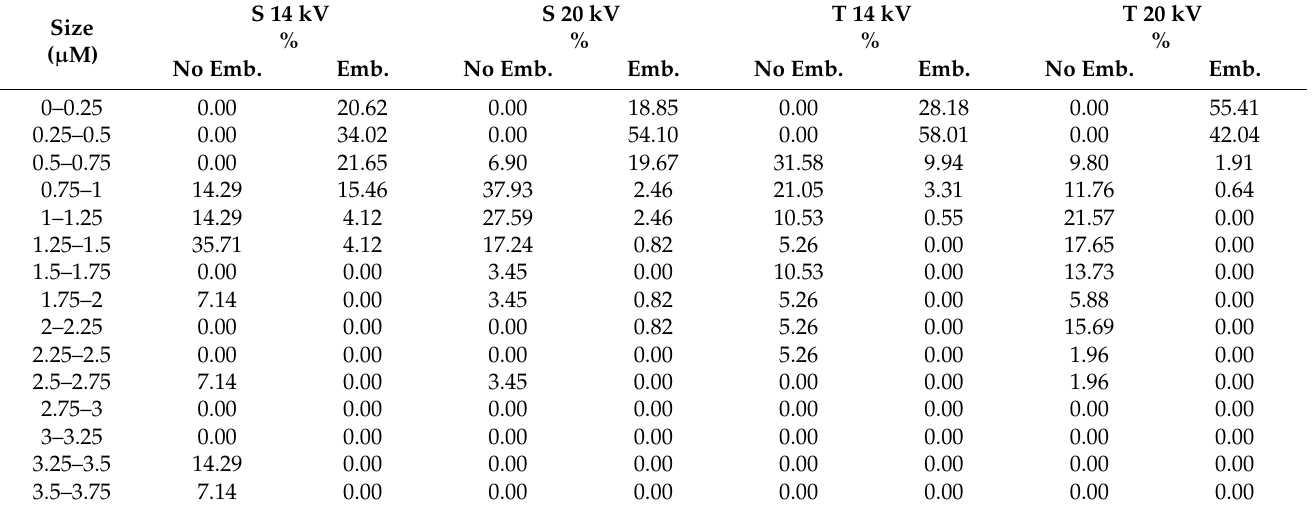
Table 4. Comparison between embedded and nonembedded spheres.